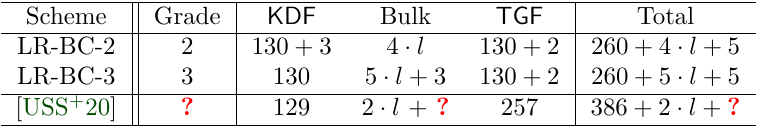
Table 1: Number of block cipher calls to encrypt l -block